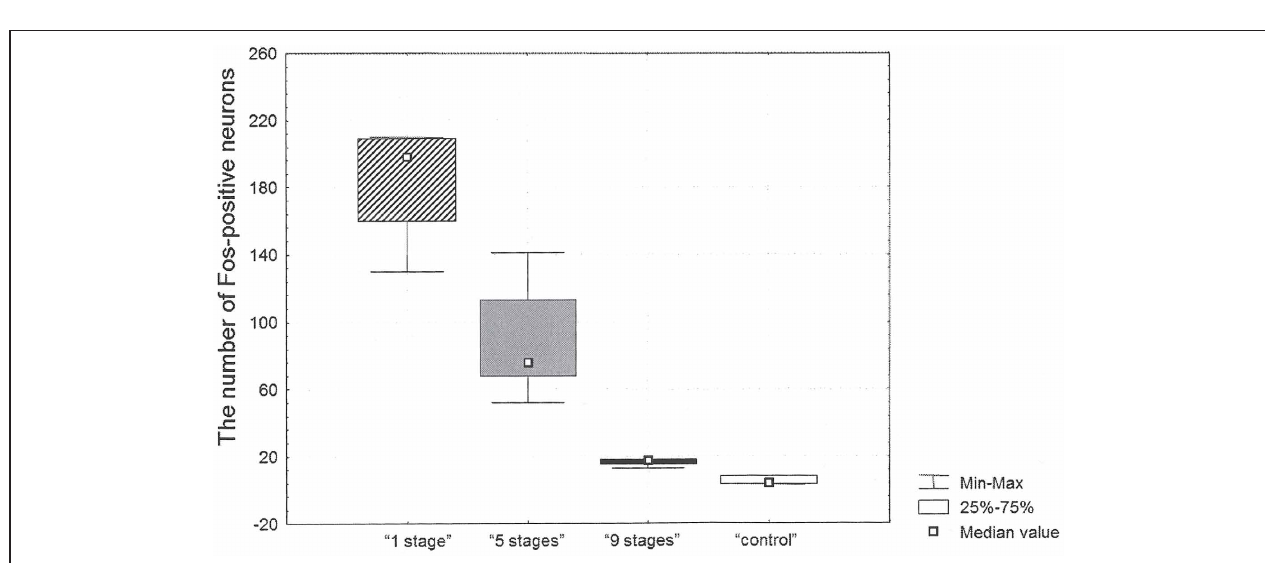
FIGURE 2 | The number of c-Fos positive neurons in the retrosplenial cortex after Task 2 acquisition in animals of “1 stage” group, “5 stages” group, “9 stages” group and “control” group.